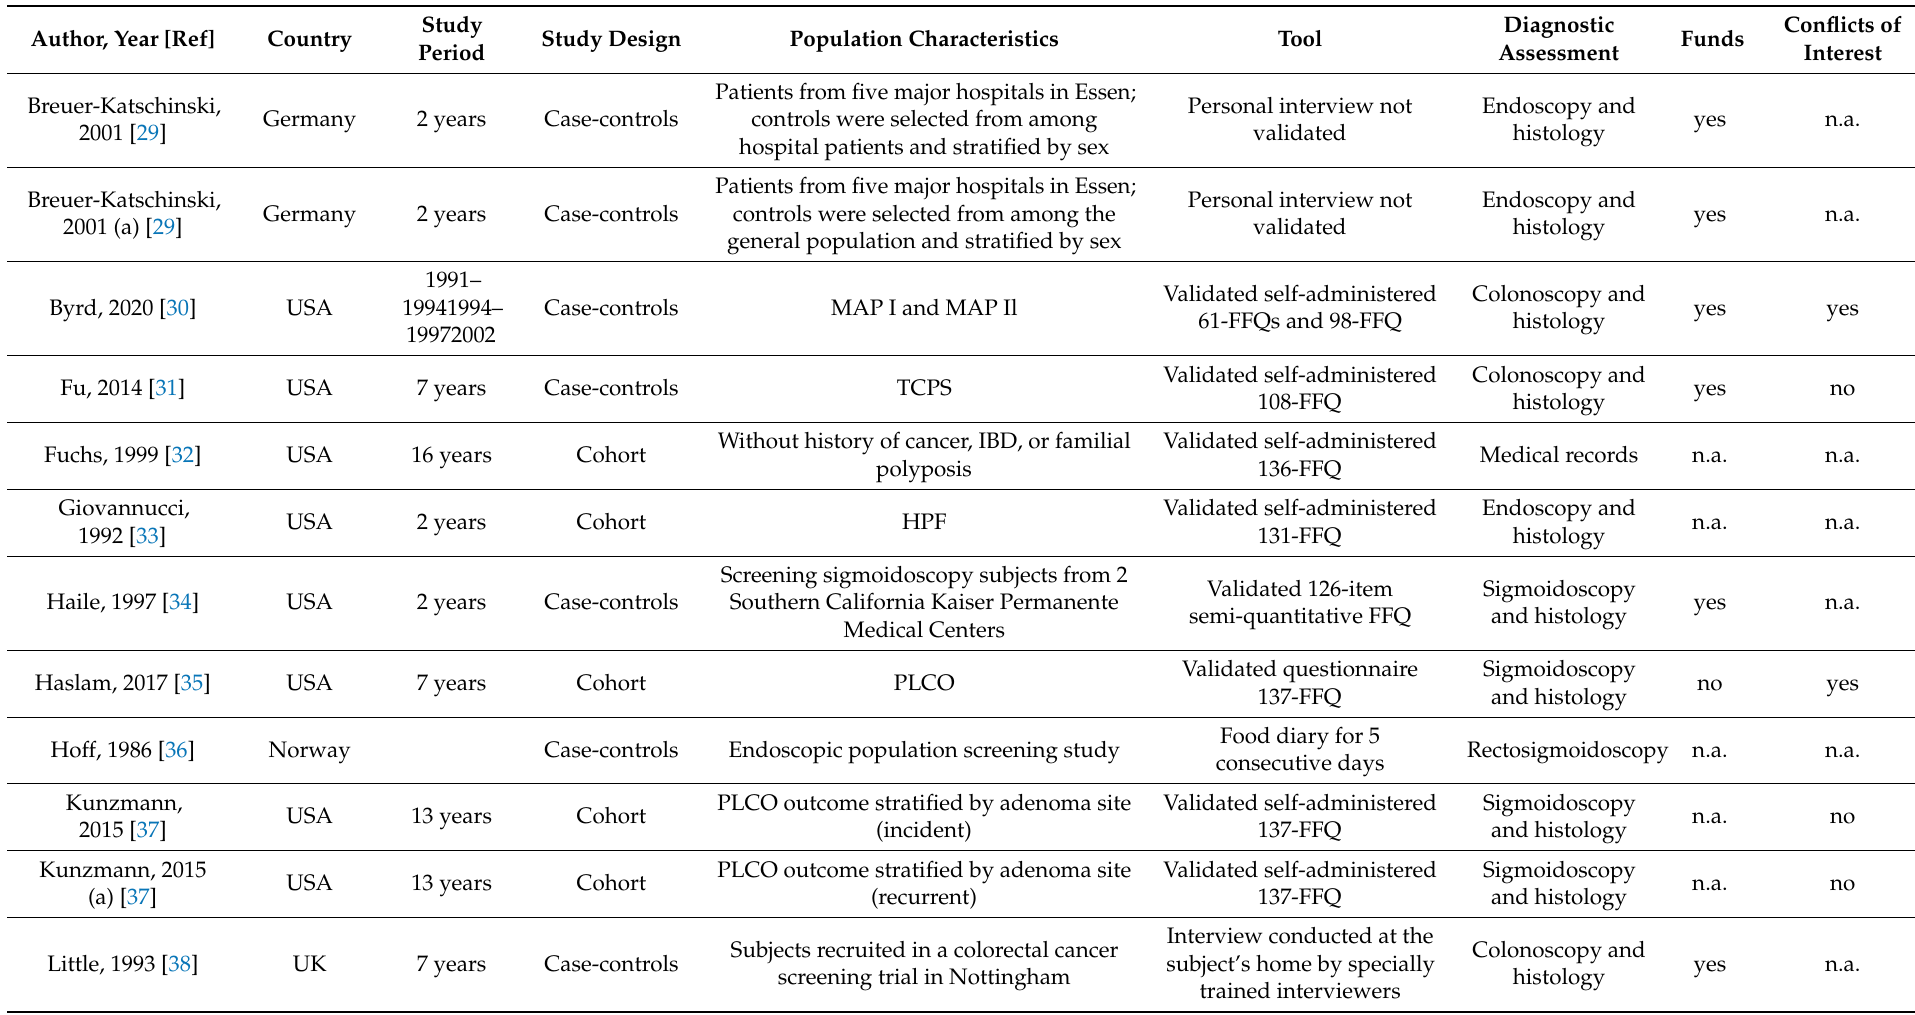
Table 1. Qualitative characteristics of included studies, reported in alphabetical